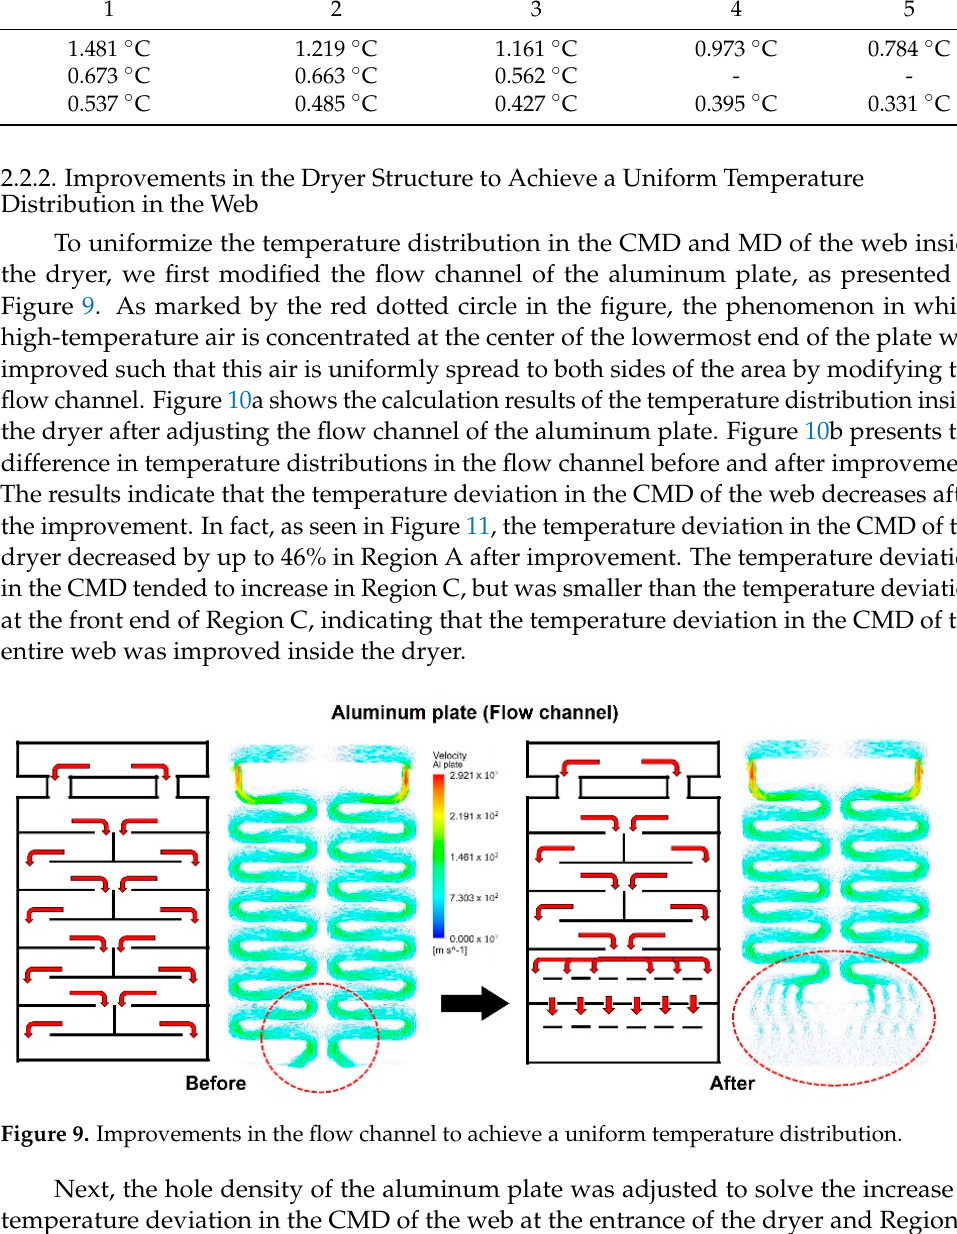
Figure 10. ( a ) Temperature distribution of the web in the dryer and ( b ) effect of flow channel improvements on the temperature distribution of the web. Figure 11. Comparison of CMD temperature deviations before and after flow channel improvements.